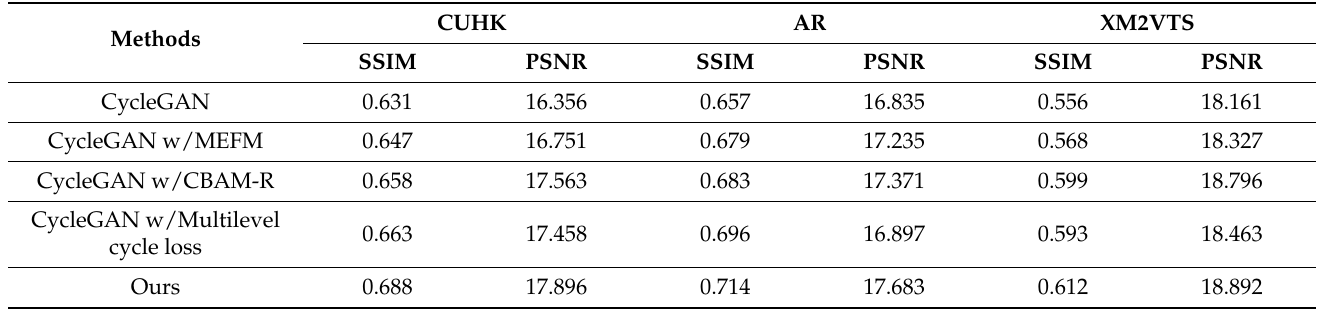
Table 4. Comparison of experimental indexes under ablation